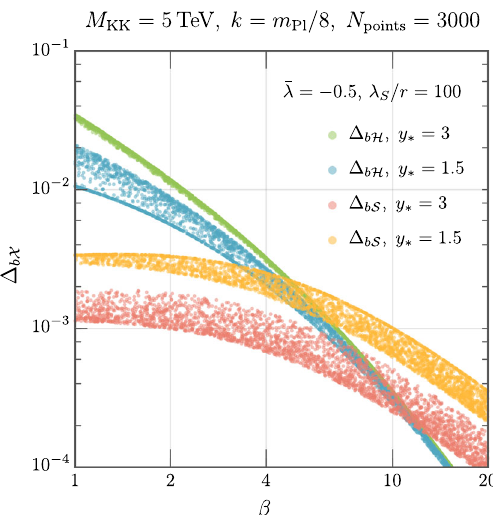
Fig. 4 (cid:22) b H and (cid:22) b S as functions of β for two different values of y ∗ and fixed values of ¯ λ , λ S / r , M KK and k / m Pl . For each case, we have generated N points = 3000 random values of c t obtained c and c b by correctly reproducing the top- and bottom- q 3 L R quark